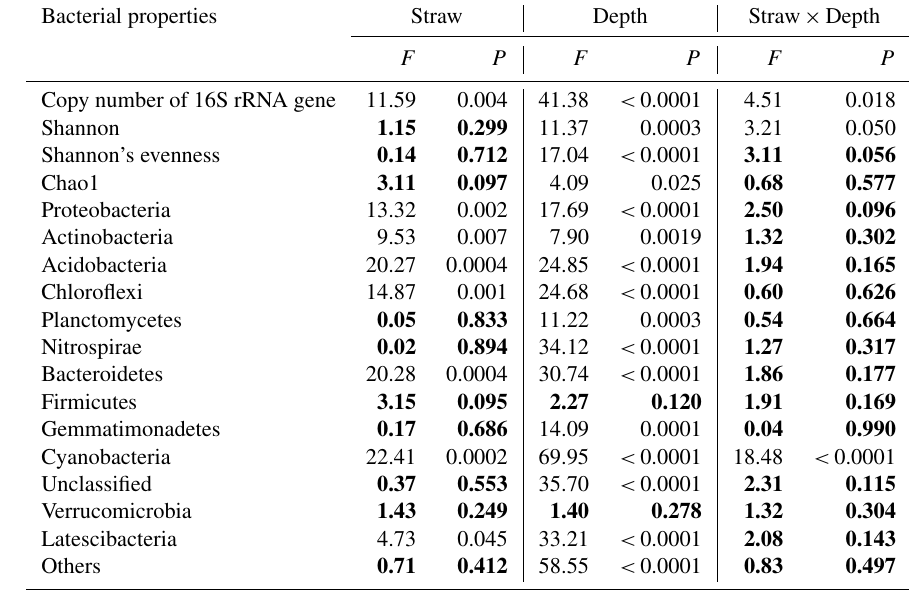
Table 3. Two-way ANOVA analysis of soil bacterial properties at four depths under two straw management strategies, each with three replicates. The data in bold indicate soil bacterial properties that were not affected by straw management strategy, soil depth, or their interaction ( P > 0 . 05).